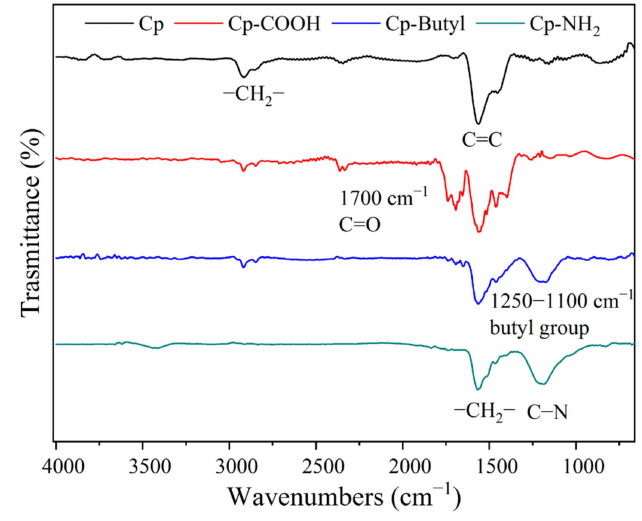
Figure 3. FTIR spectra of Cp, Cp − COOH, Cp − butyl and Cp − NH 2 . Table 2. Pd and Au contents in the